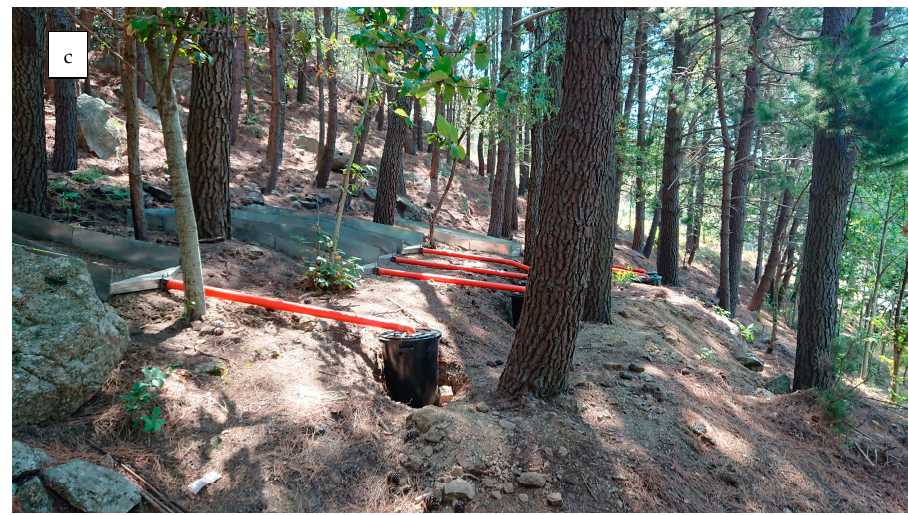
Figure A2. Experimental areas unburned or subjected to prescribed fire and mulching with fern (Samo, Calabria, Southern Italy). ( a ) oak; ( b ) chestnut; ( c ) pine.